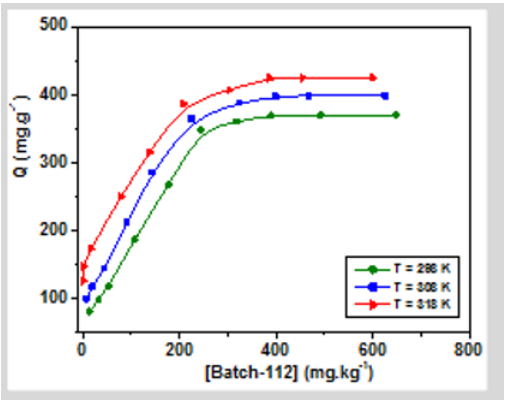
Fig. 8. Adsorption isotherms of chitosan (batch-112) on AC Norit A SUPRA EUR sterilized, at three